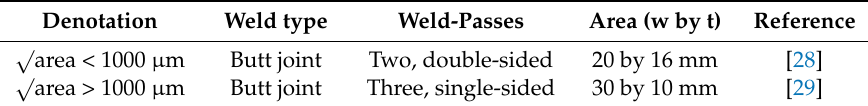
Table 1. Overview of investigated test